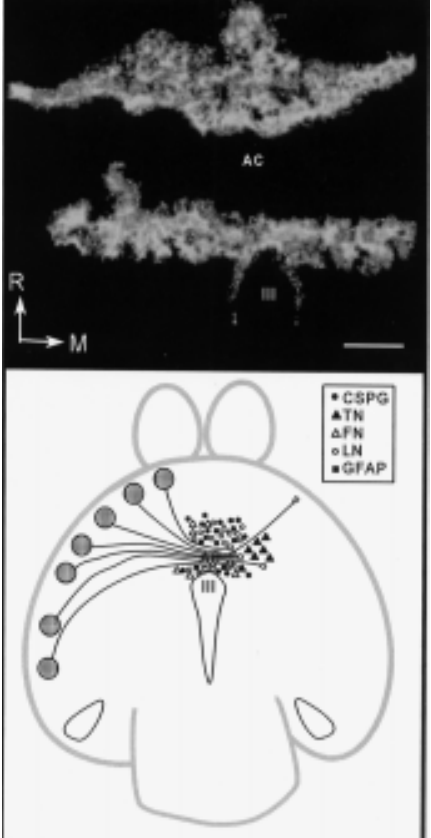
Figure 1 - Top , Horizontal section through an E14 brain rostral to the third ventricle (III) displaying a mid- line laminin (LN) tunnel that appears while commissural axons cross the anterior commissure (AC) region. Rostral (R) is upwards and medial (M) is to the right. Calibration bar = 150 µm. Bottom , Schematic repre- sentation of molecular expression of chondroitin sulfate proteoglycan (CSPG), tenascin (TN), LN and fibro- nectin (FN) around the AC bundle during the same developmental stage. GFAP, Glial fibrillary acidic